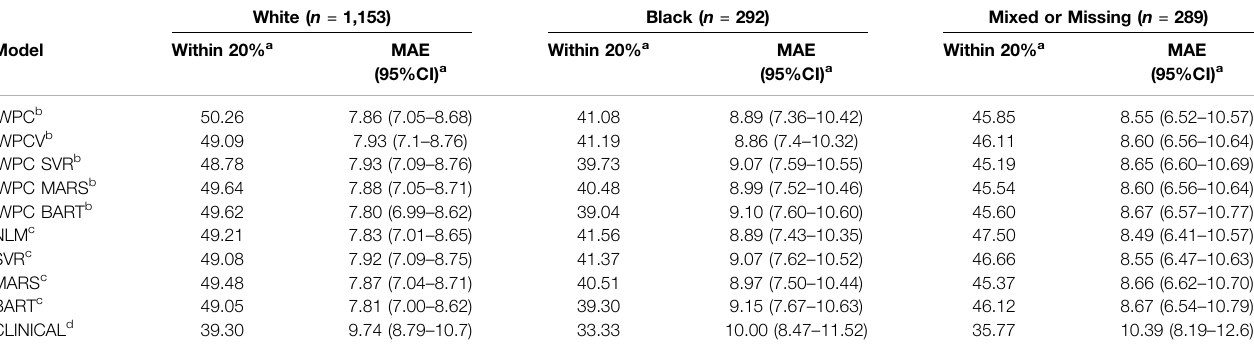
TABLE 3 | Model comparisons by race data in the ULLA cohort ( n (cid:1) 1,734).